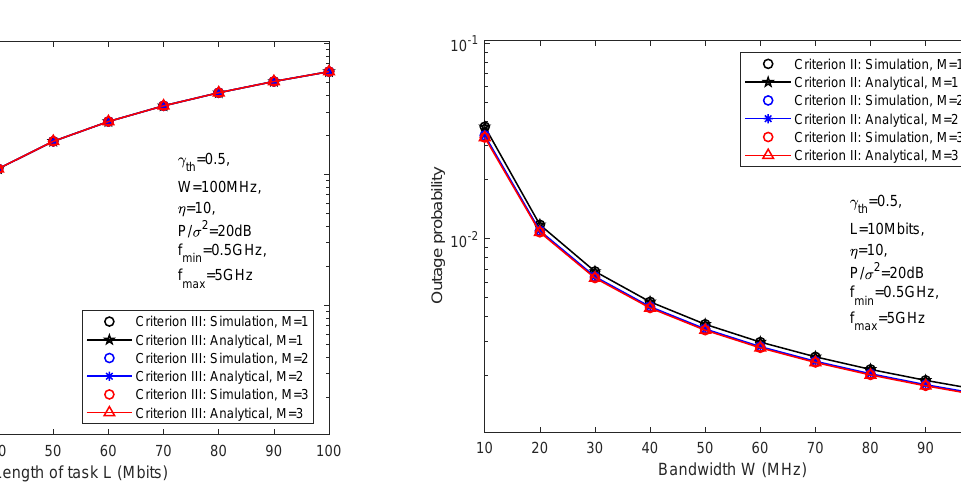
Figure 6. Outage probability versus bandwidth W for criterion II.